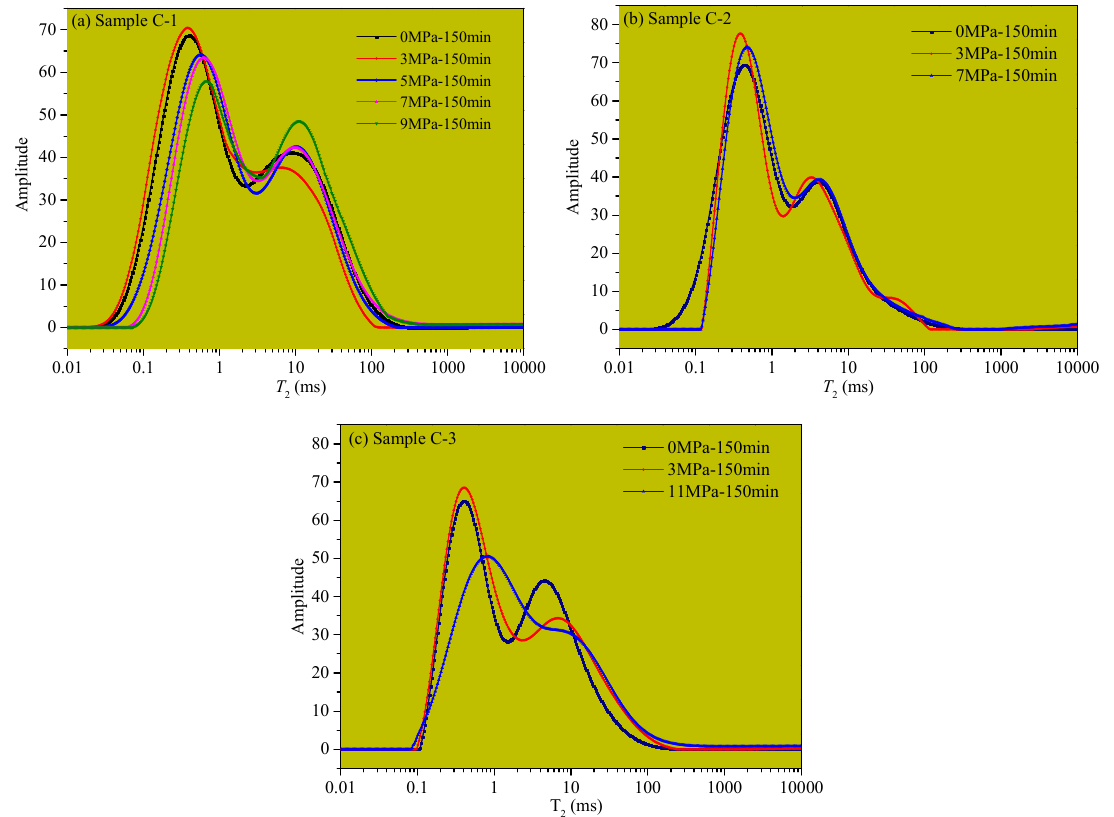
Figure 10. T 2 distribution curves of the coal samples in Group C: ( a ) Sample C-1, ( b ) Sample C-2, ( c ) ( c ) Sample Sample C-3.